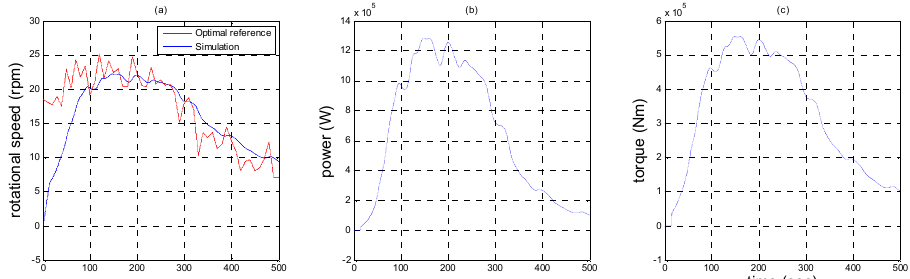
Figure 19. Pitch angle tracking control in region 2: ( a ) Pitch 1; ( b ) Pitch 2; ( c ) Pitch 3; ( d ) Pitch 1 tracking error; ( e ) Pitch 2 tracking error; ( f ) Pitch 3 tracking error.